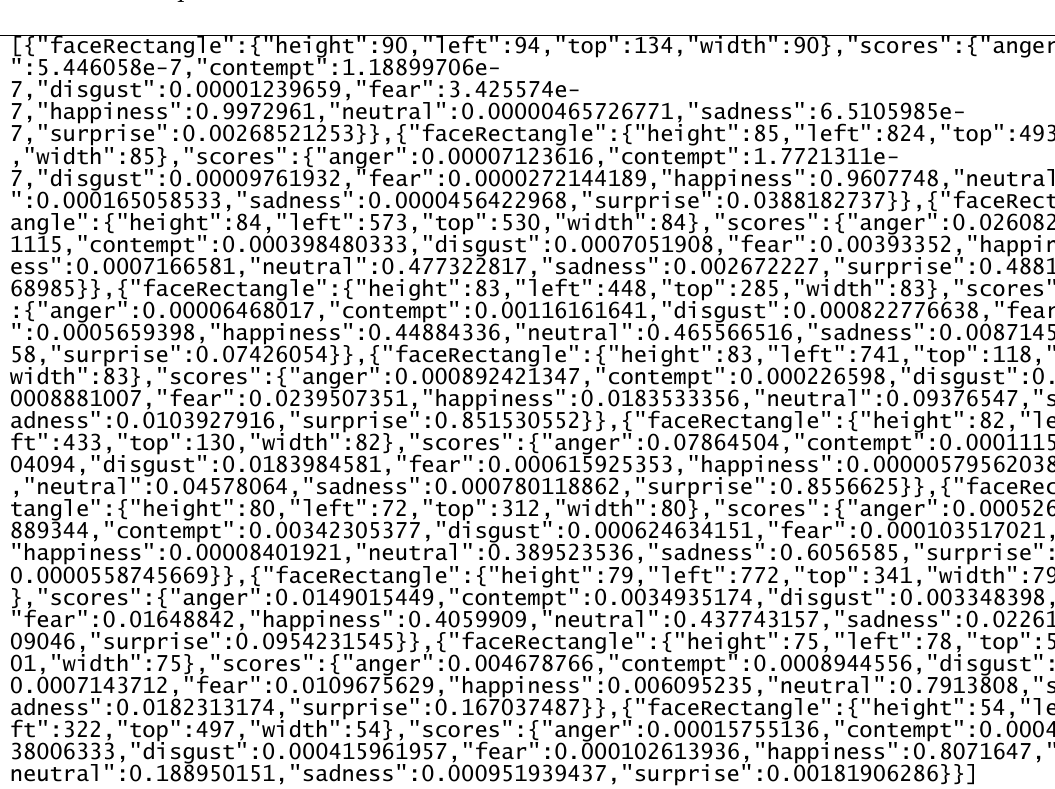
Figure 2. Sample image 2 and related API output.